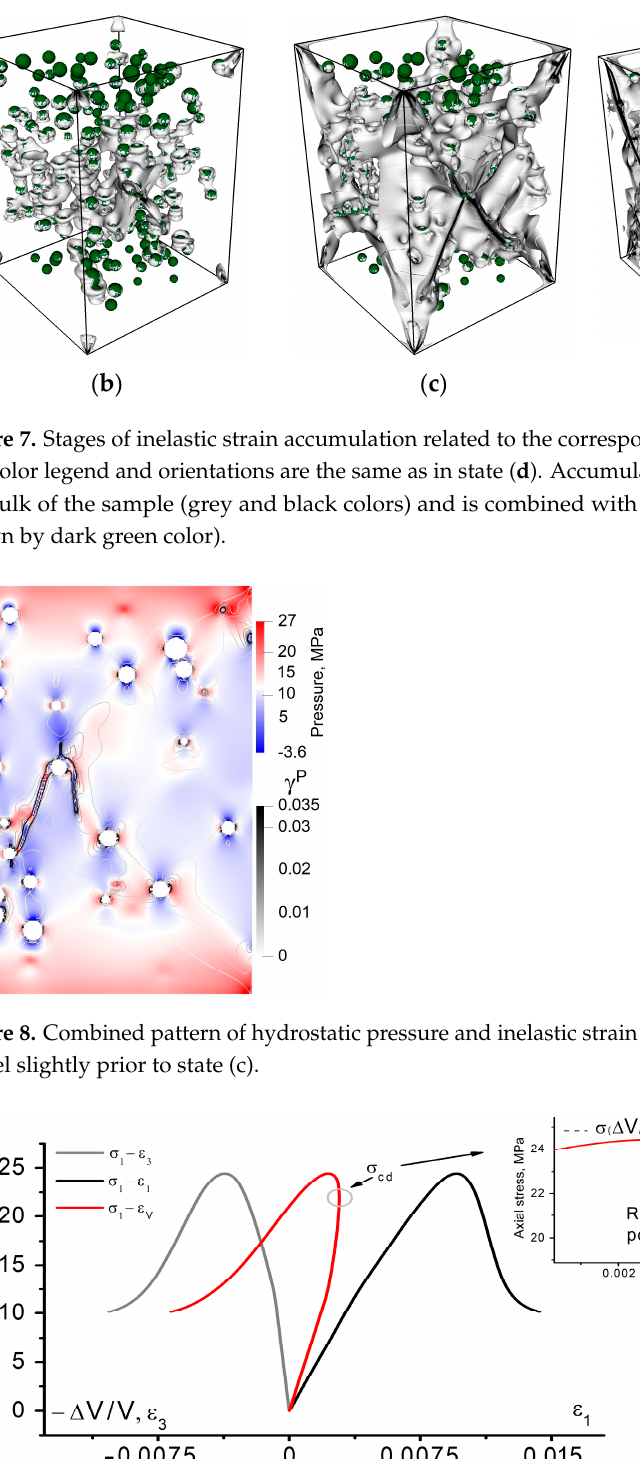
Figure 9. Complete stress-strain curve obtained by numerical modeling. Processing the complete stress-strain curve allowed us to obtain the curves of de- pendence of